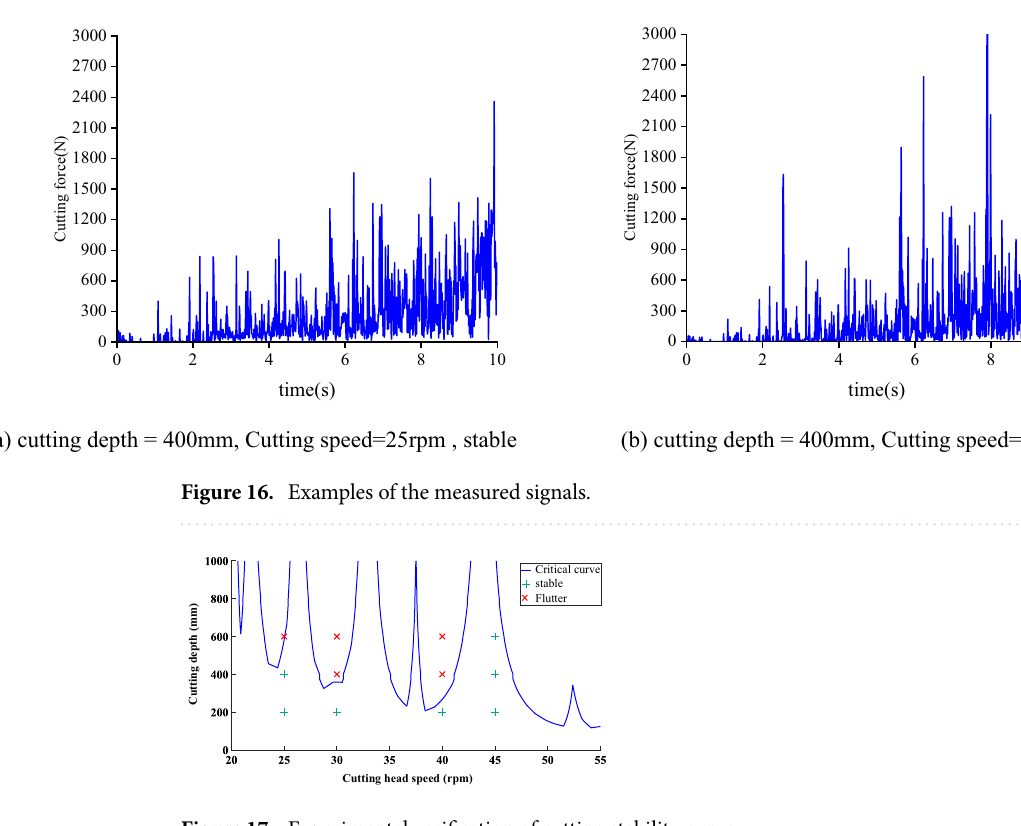
Figure 17. Experimental verification of cutting stability curve.